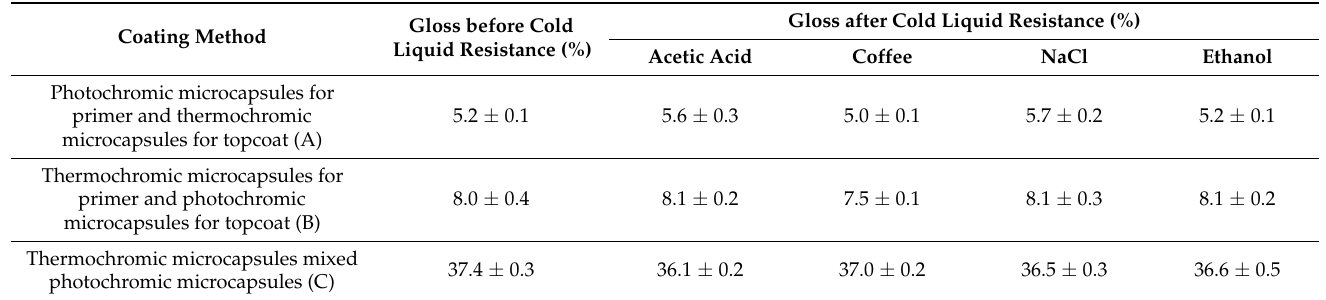
Table 11. Gloss of surface coating on Basswood under different coating processes before and after cold liquid resistance.